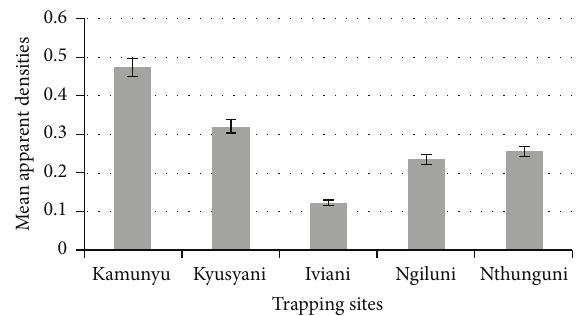
Figure 6: Comparison of mean apparent densities within the five trapping